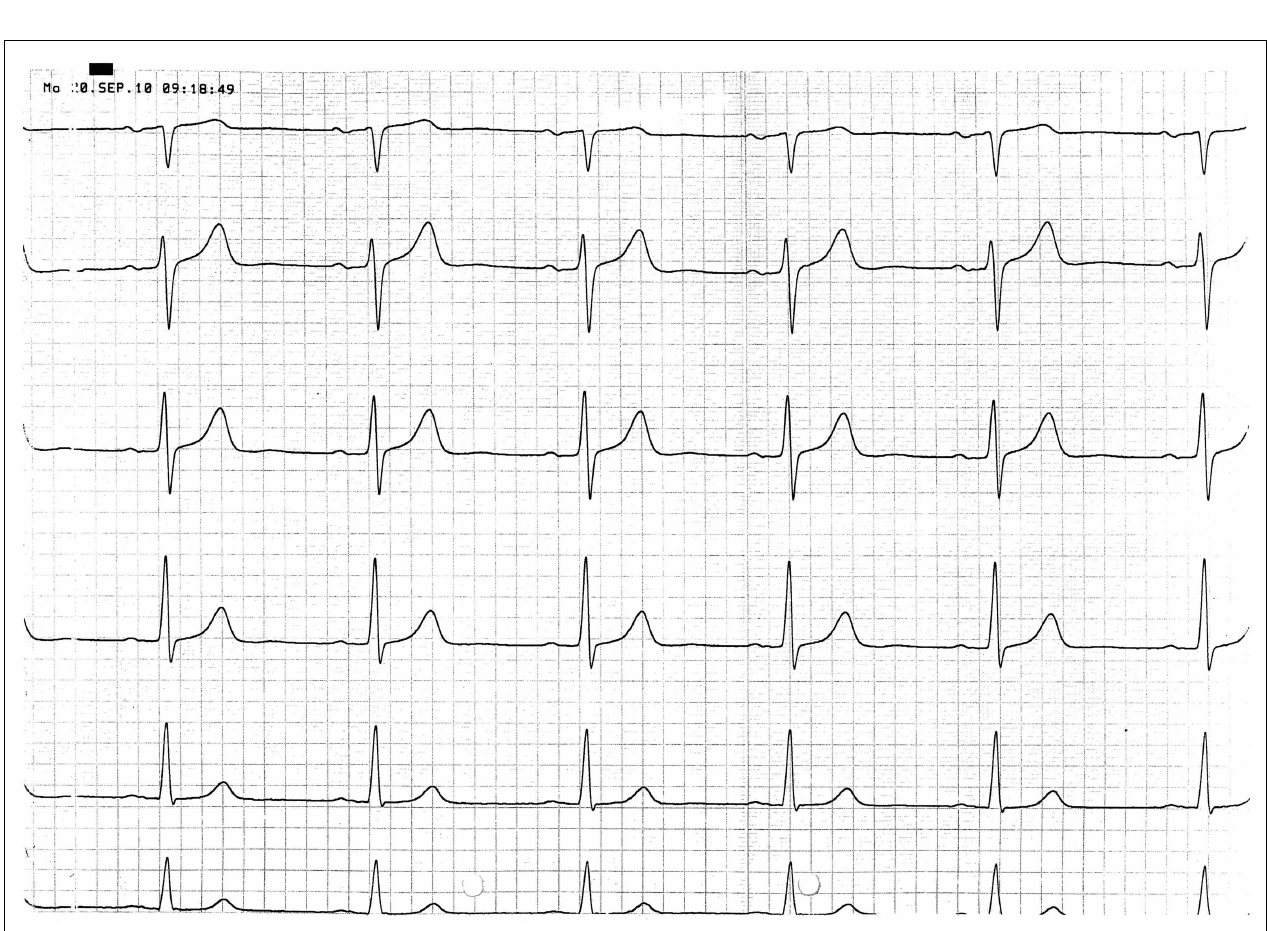
FIGURE 3 | ECG at follow-up 6 weeks after LBBB (patient